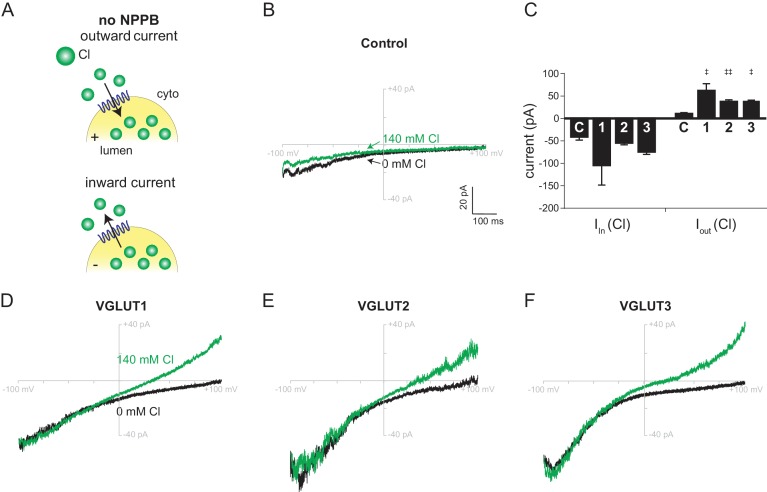
Chloride currents in endosomes without lumenal NPPB.(A) Whole endosome recording conditions with 140 mM Cl- at pH 5.0 but no NPPB in the pipette (lumen). Representative recordings from cells expressing only rab Q79L (B), VGLUT1 (D), VGLUT2 (E) and VGLUT3 (F), using voltage ramps as described in Figure 1. (C) Maximum inward and outward currents, with 140 mM external gluconate (0 Cl-) used to define the baseline outward current, and no baseline subtraction for the maximum inward current (n = 3–8). Bar graph indicates mean ± SEM. C, control; 1–3, VGLUT1-3 and statistical comparisons are made to C. ‡p<0.01, ‡‡p<0.001 by Mann-Whitney test.